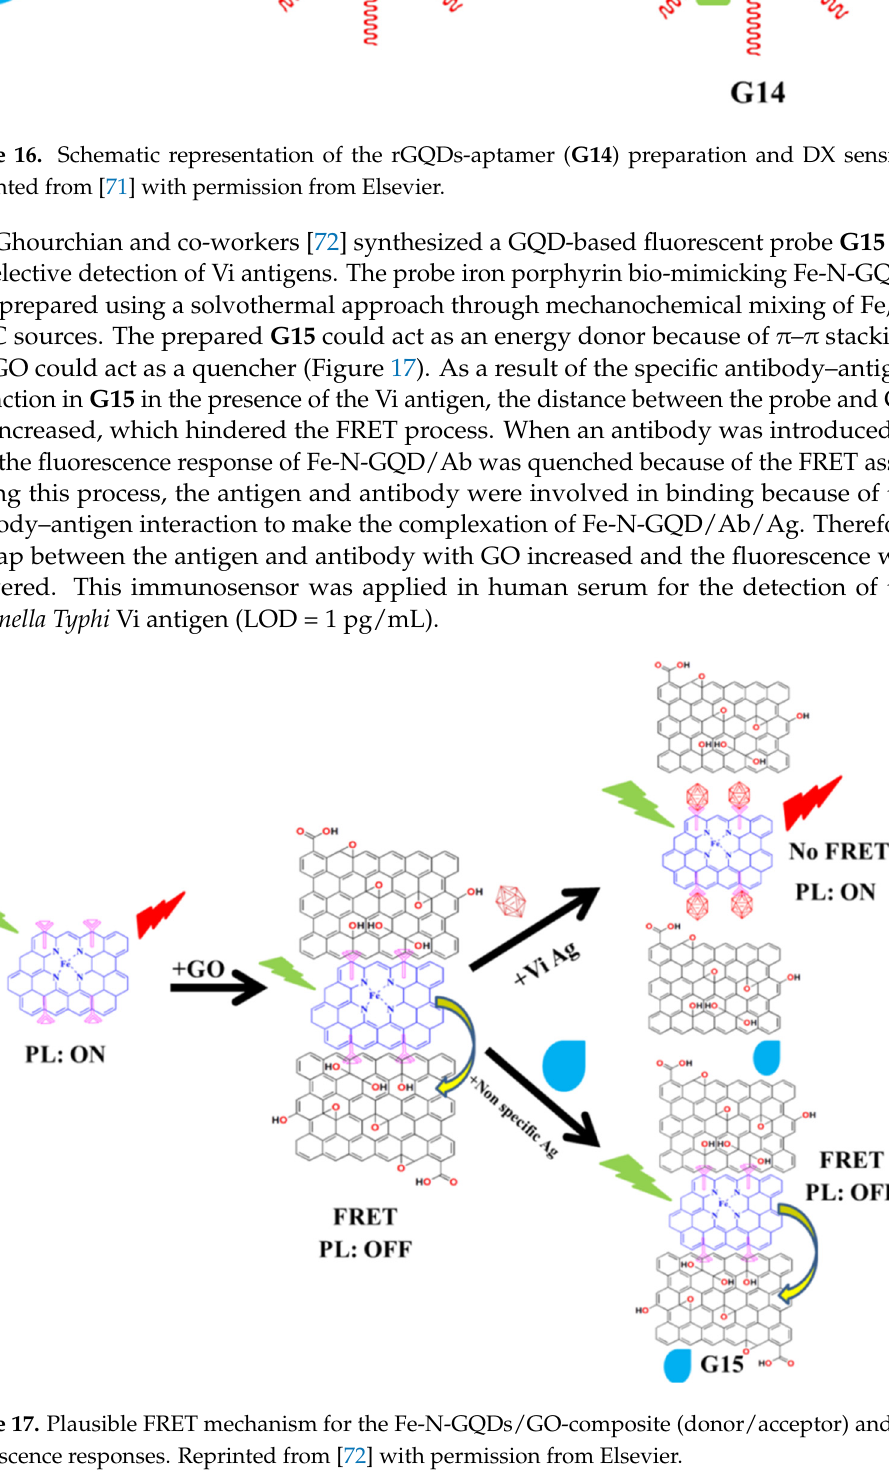
Figure 16. Schematic representation of the rGQDs-aptamer ( G14 ) preparation and DX sensing. Reprinted from [71] with permission from Elsevier.